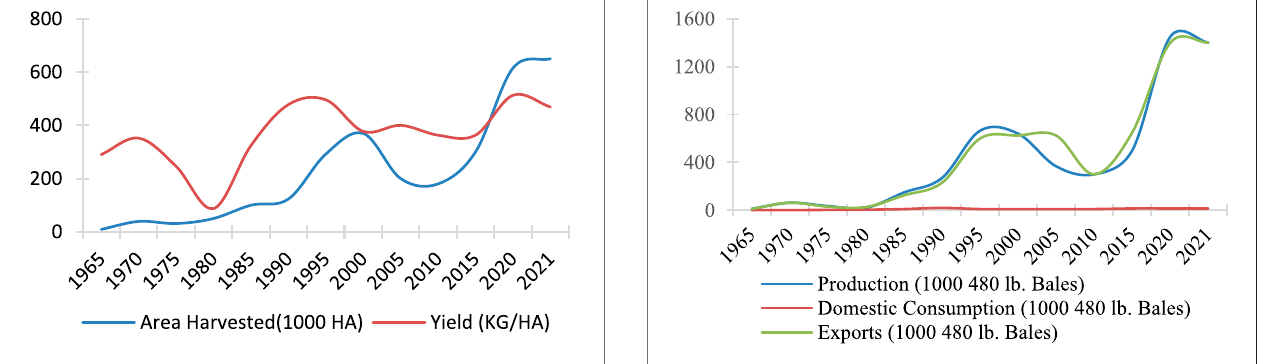
FIGURE 2 | Cotton production in Benin. Source: Authors with data from USDA,